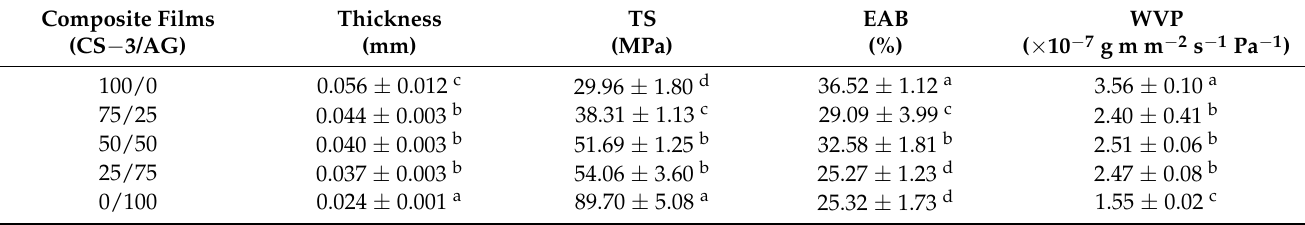
Table 3. Thickness, tensile strength (TS), elongation at break (EAB) and water vapor permeability (WVP) of CS/AG composite films with various